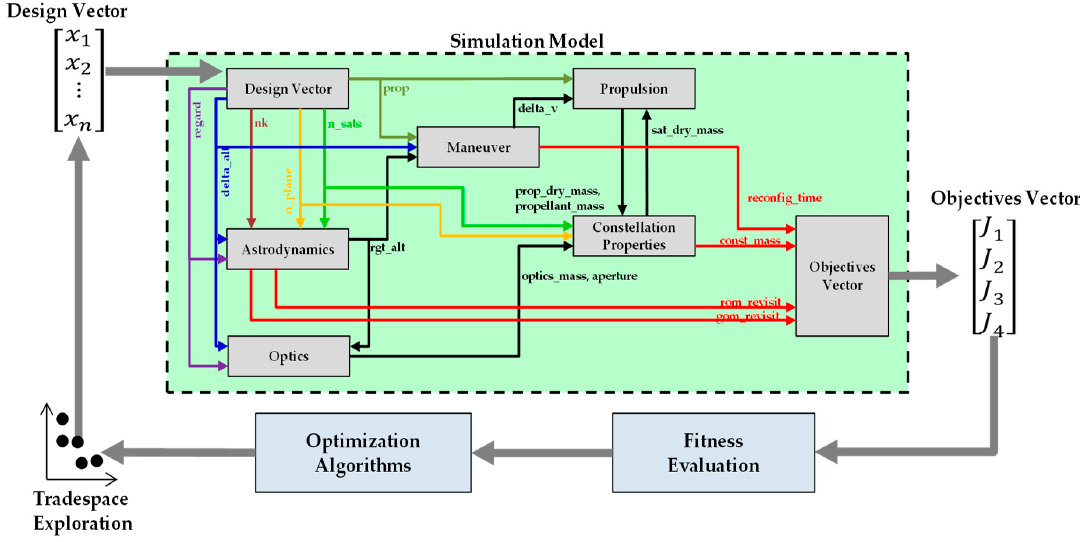
Figure 8. ReCon optimization framework.